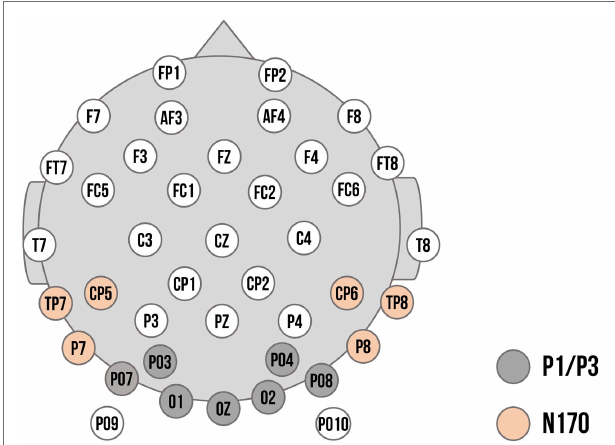
FIGURE 2 | Electrode montage with channel locations used as regions of interest (ROIs). Dark grey: Channels used for the P1 and P3 component. Orange: Channels used for the left and right cluster for the N170